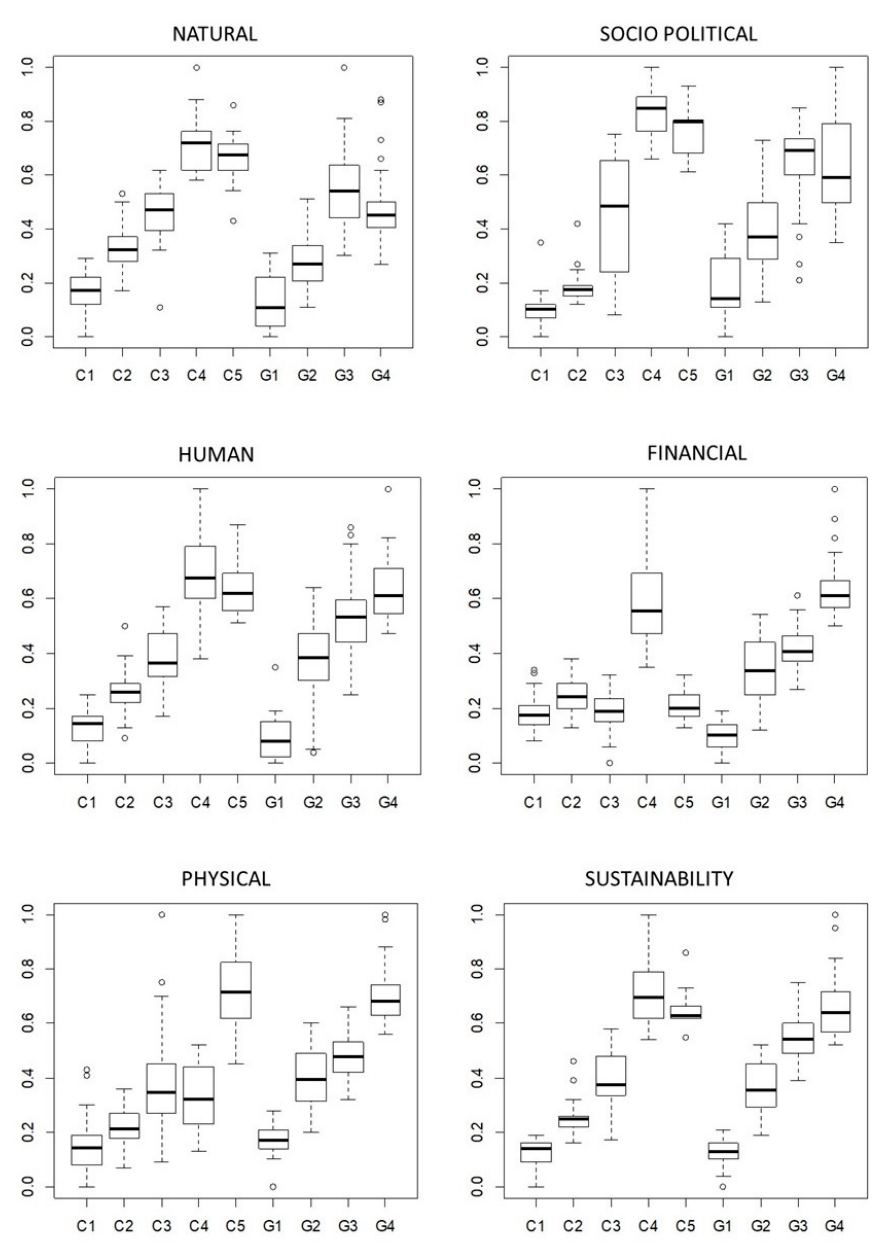
Figure 7. Variations in the five capital indices and sustainability index among clusters of the two systems. C: small-scale agricultural system, G: cattle ranching system. C1 to C5: small-scale family agricultural clusters; G1 to G4: cattle ranching clusters.